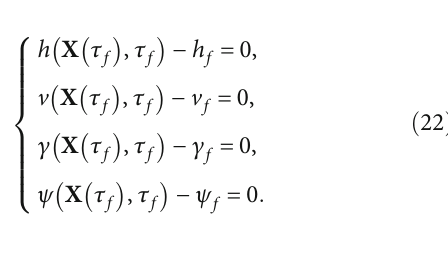
Figure 29: Change rate of sideslip Taking K ‐ th Legendre-Gauss points f τ = − 1 as nodes, the K + 1 ‐ th Lagrange interpolation polyno- mials are formed as basis functions to approximate the states.